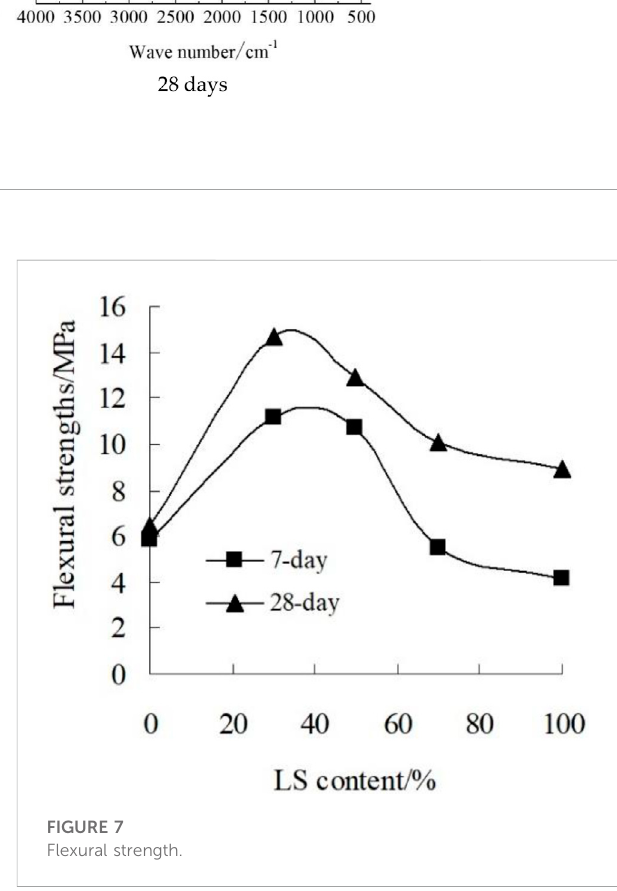
FIGURE 6 Unit weight. FIGURE 7